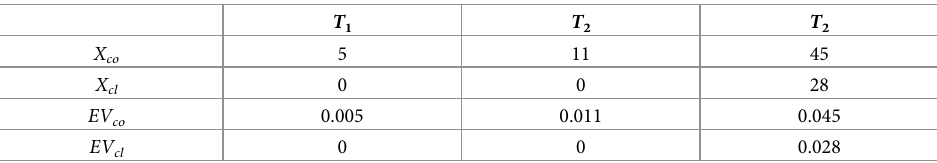
Table 2. The values of EX co and EX cl for three selected drug